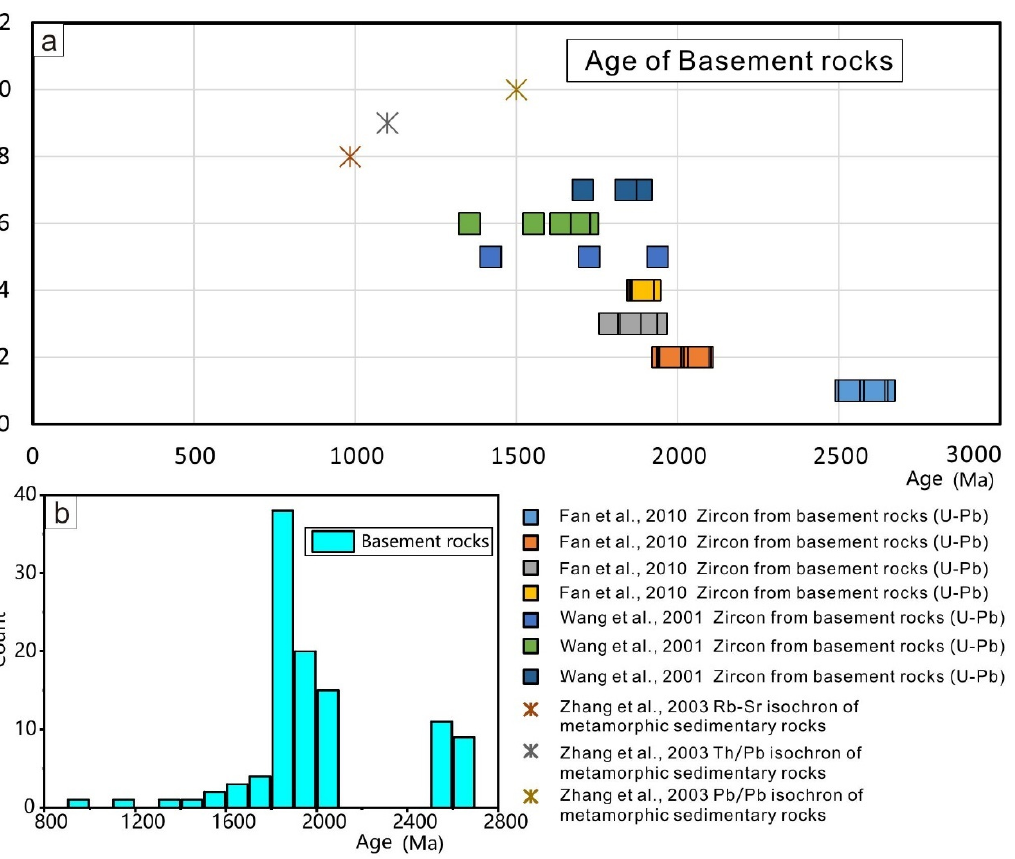
Figure 11. Age distribution characteristics of basement rocks. ( a ) Single age distribution character- istics corresponding to different studies. ( b ) Stack histograms of all ages.